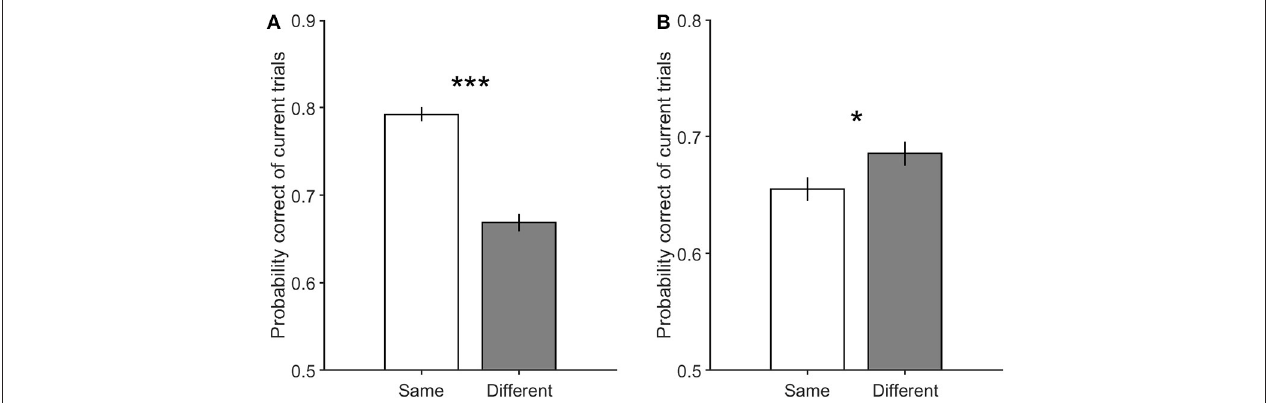
FIGURE 5 | The performance of the current trials with motion strengths of 3.2, 6.4, and 12.8%. (A) shows performance in the current trials when previous trials have low motion strengths of 0 and 3.2%. (B) illustrates performance in the current trials when previous trials have high motion strengths of 12.8 and 51.2%. Error bars indicate SE (Standard Error). Wilcoxon rank-sum test is used to test the significance of the differences, * p < 0.05, *** p < 1E − 3.